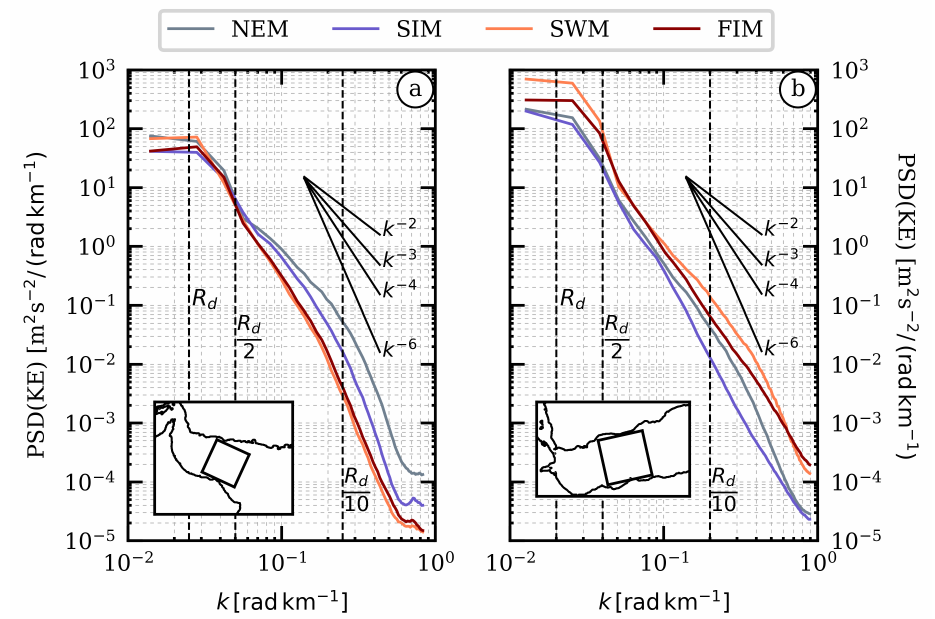
Figure 3. Power Spectrum Densities (PSDs) of horizontal surface velocities computed ( a ) in the Gulf of Oman, and ( b ) in the Gulf of Aden (see square boxes drawn in insets for the computional domains). PSDs are timely averaged for (gray) the North-East Monsoon (NEM), (blue) the Spring Inter-Monsoon (SIM), (orange) the South-West Monsoon (SWM), and (red) the Fall Inter-Monsoon (FIM). Solid black lines stand for benchmarks of power laws, and information about the deformation radii and wavelengths (i.e., R d , R d /2, and R d /10) is indicated in dashed black